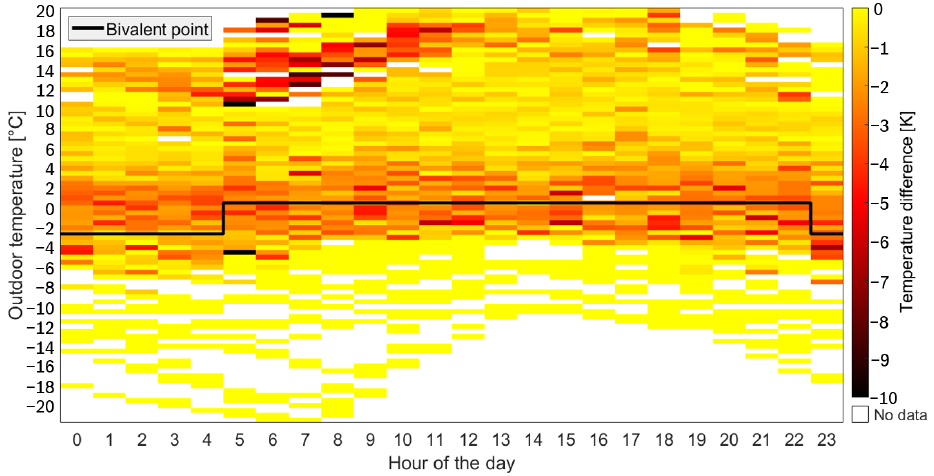
Figure 15. Negative temperature differences of 15 min periods in dependency of the outdoor temper- ature and time of the day with bivalent point.